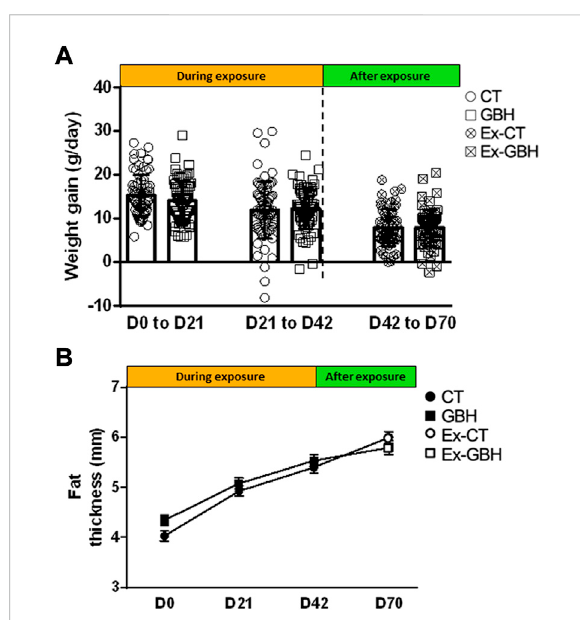
FIGURE 3 Body weight gained (A) and fat thickness (B) during dietary GBH exposure (D0 to D42; CT, n = 75; GBH, n = 75) and after (D42 to D70; Ex-CT, n = 66; Ex-GBH, n = 66) dietary GBH exposure. Results are presented as means ± SEM (A) and as means (B) . CT: Control, GBH: Glyphosate-Based Herbicide, Ex- CT: Ex-Control,